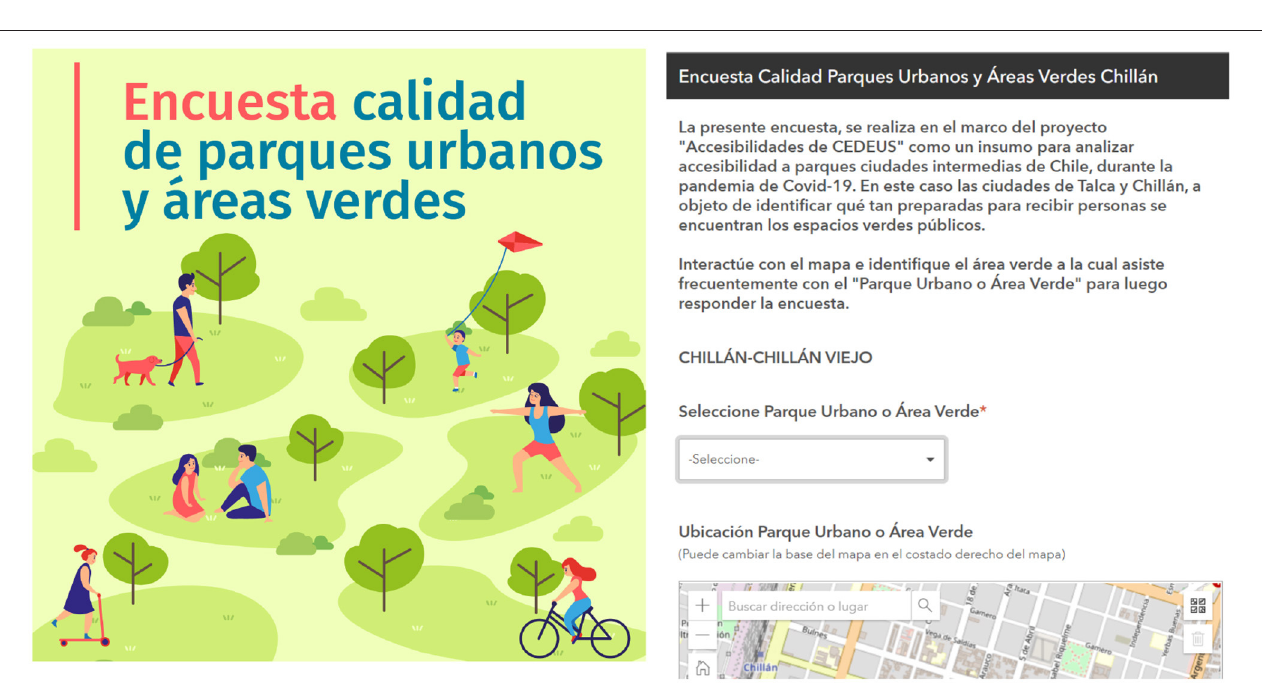
FIGURE 4 | Spanish language invitation and initial survey form on the quality of parks and green areas (for links to the survey form see the Data section).